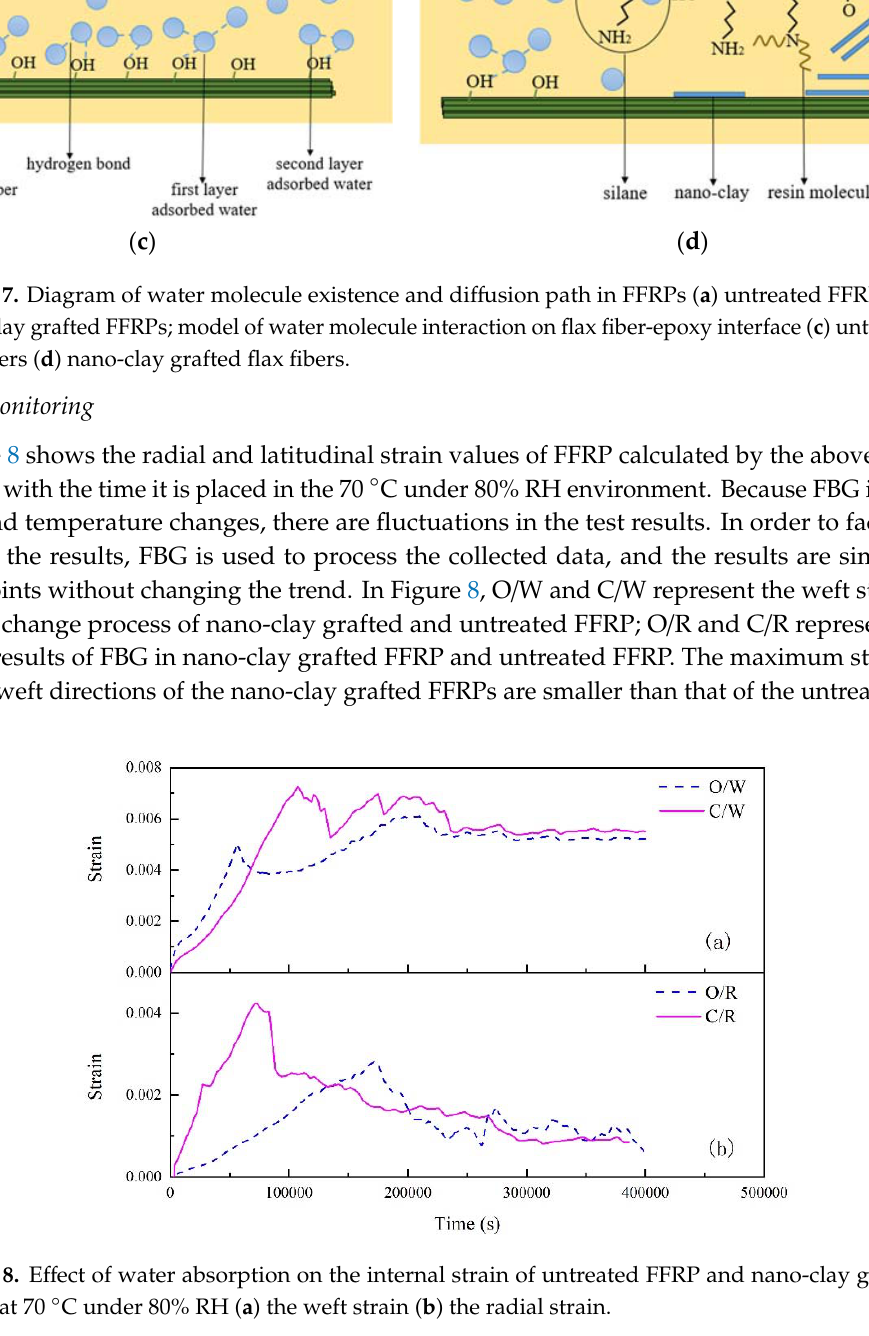
Figure 8. Effect of water absorption on the internal strain of untreated FFRP and nano ‐ clay grafted FFRPs at 70 ◦ C under 80% RH ( a ) the weft strain ( b ) the radial FFRPs at 70 °C under 80% RH ( a ) the weft strain ( b ) the radial strain.